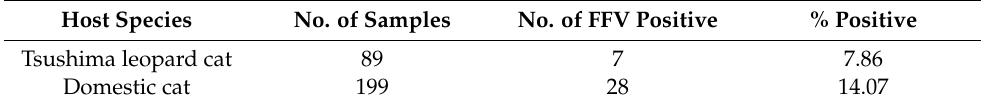
Table 2. FFV detected in feline DNA sample by nested PCR.